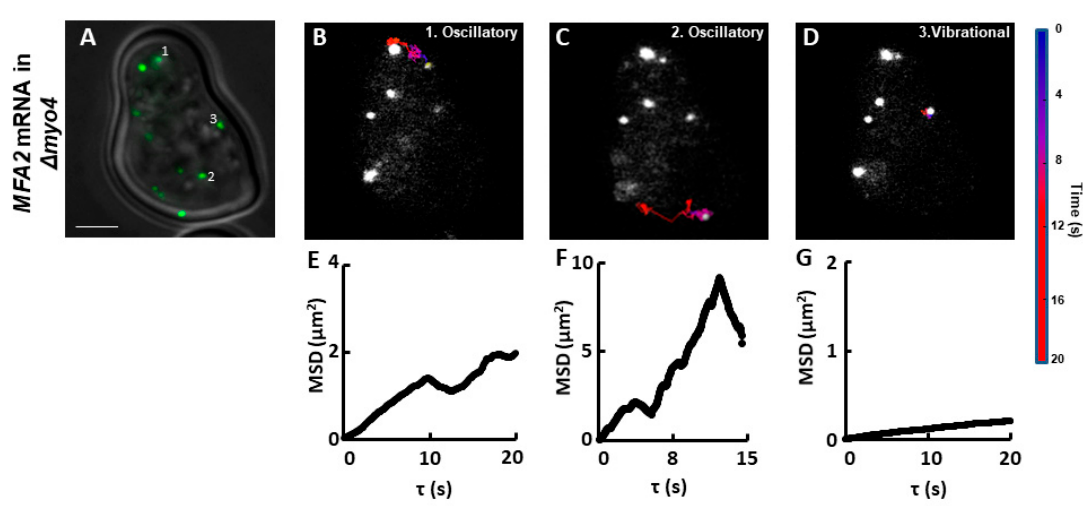
Figure 9. MFA2 granules in ∆ myo4 yeast did not exhibit fast translocational movement to the shmoo. ( A ). ∆ Myo4 cells expressing labeled MFA2 mRNA were treated with pheromone for 2 h and recorded at 0.055–0.07 s time intervals for 60 s. Scale bar = 2 µ m also applies to ( B – D ). ( B – D ) Tracks of three particles in mutant cells were limited to two motility types: vibrational and oscillatory. The color scale refers to time. ( E – G ) Each MSD profile corresponds to the track presented above it in panels ( B – D ).